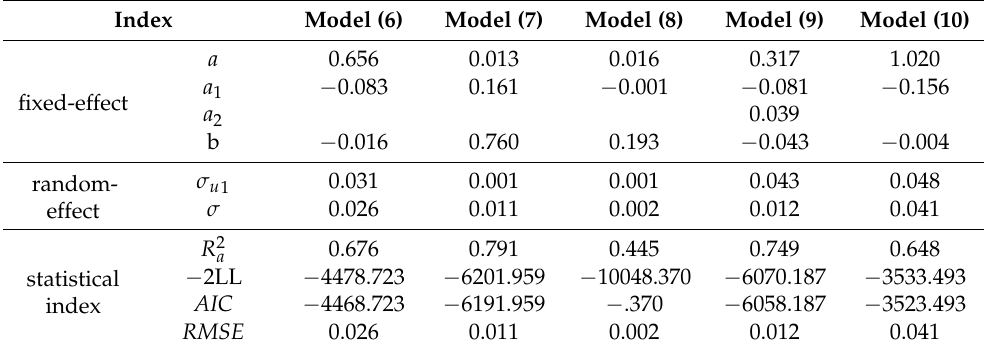
Table 8. Fitting Statistics of the Mixed-Effects Model.